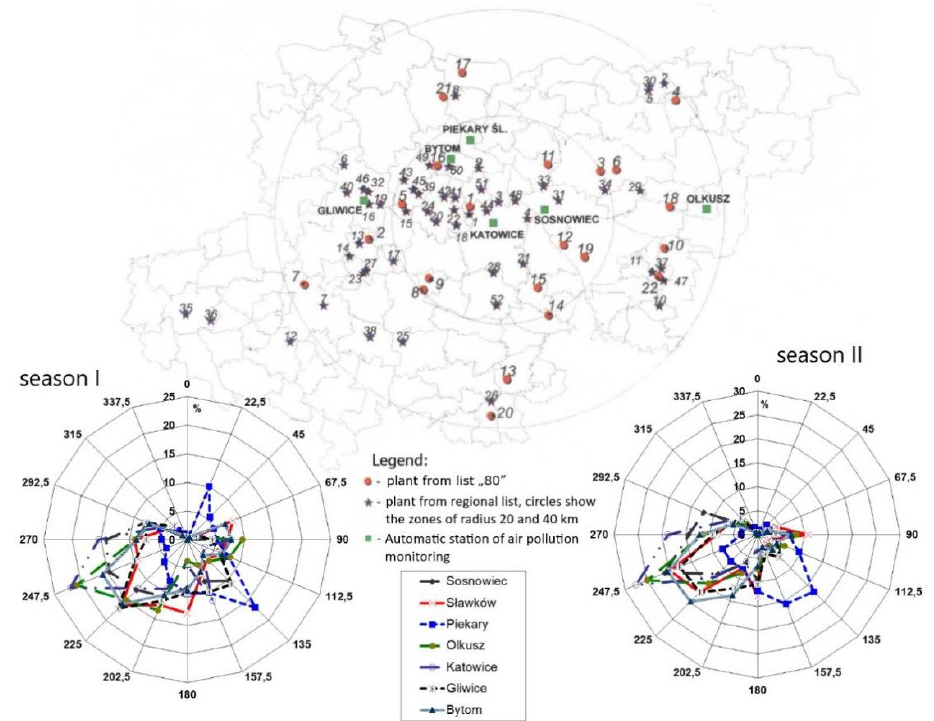
Figure 4. Location of industrial plants and measuring stations in the Upper Silesian Industrial Region and wind roses for analyzed heating seasons 1996–1997 and 1997–1998 with wind roses [7]. Table 4. Summary statistics for data in individual